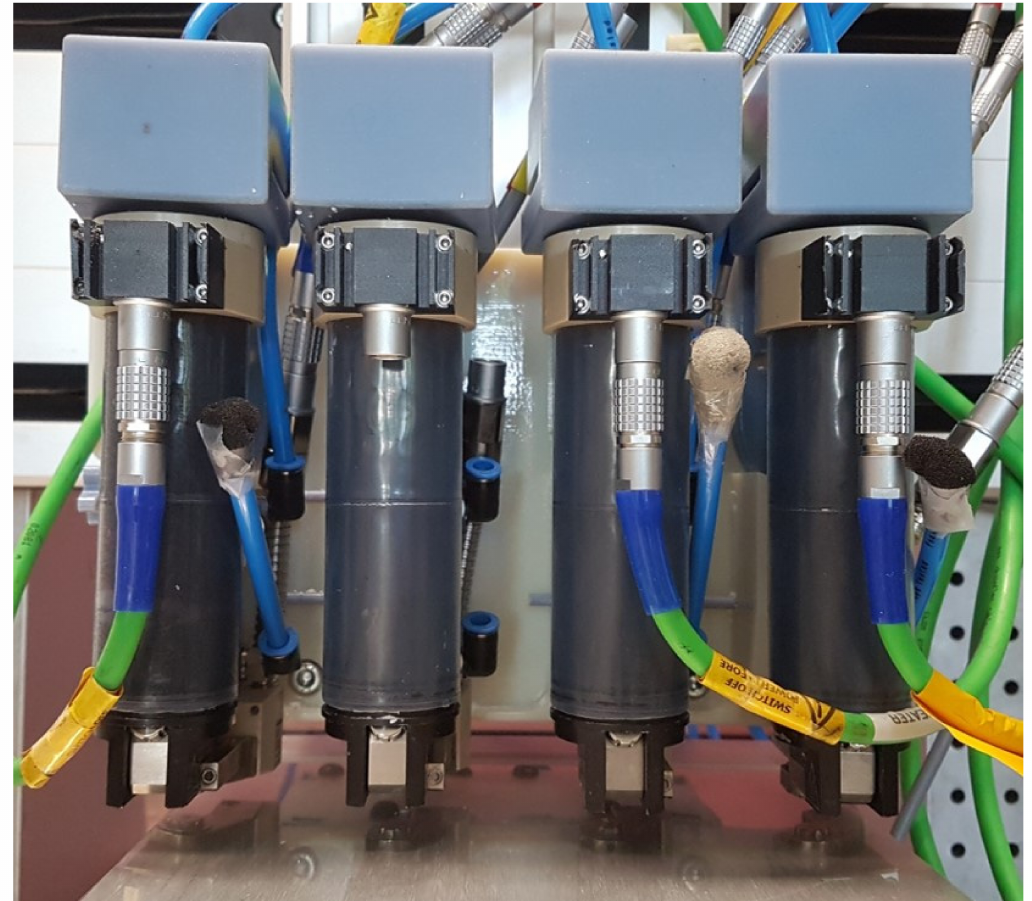
Figure 8. Thermoplastic 3D printing (T3DP) device with four different micro dispensing